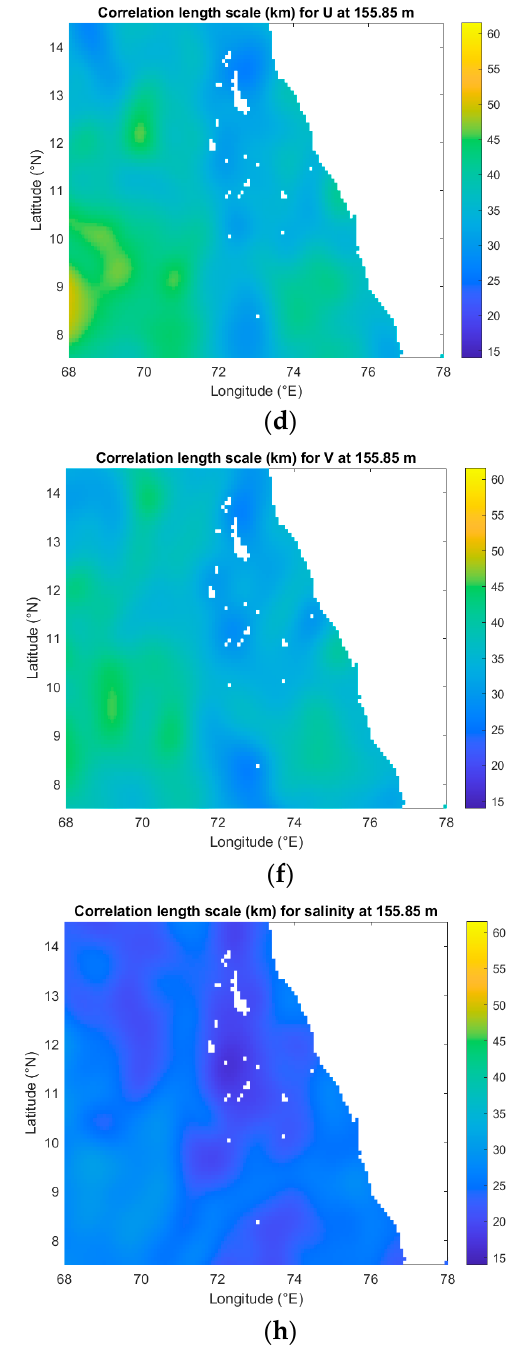
Figure 3. Spatial distribution of the short correlation length at the sea surface (left panels) and 156 m depth (right panels) for the following variables: ( a , b ) temperature, ( c , d ) U-component of current velocity, ( e , f ) V-component of current velocity, ( g , h ) salinity. The units in the colour bar are kilometres. The downscaled value for the variable (cid:103) Q m , where m is a node number on the child mesh, was calculated using Equation (4)